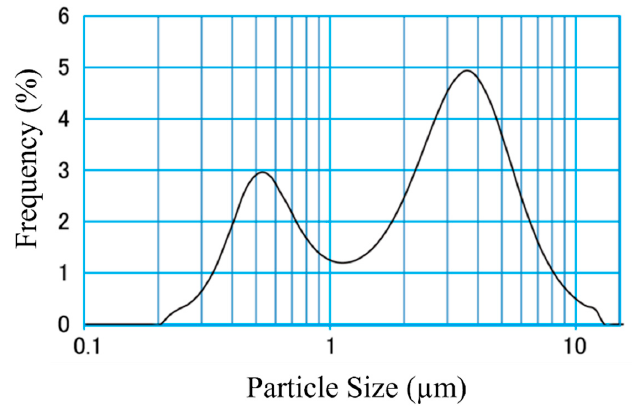
Figure 1. Particle size distribution of the Al 2 O 3 powder material.